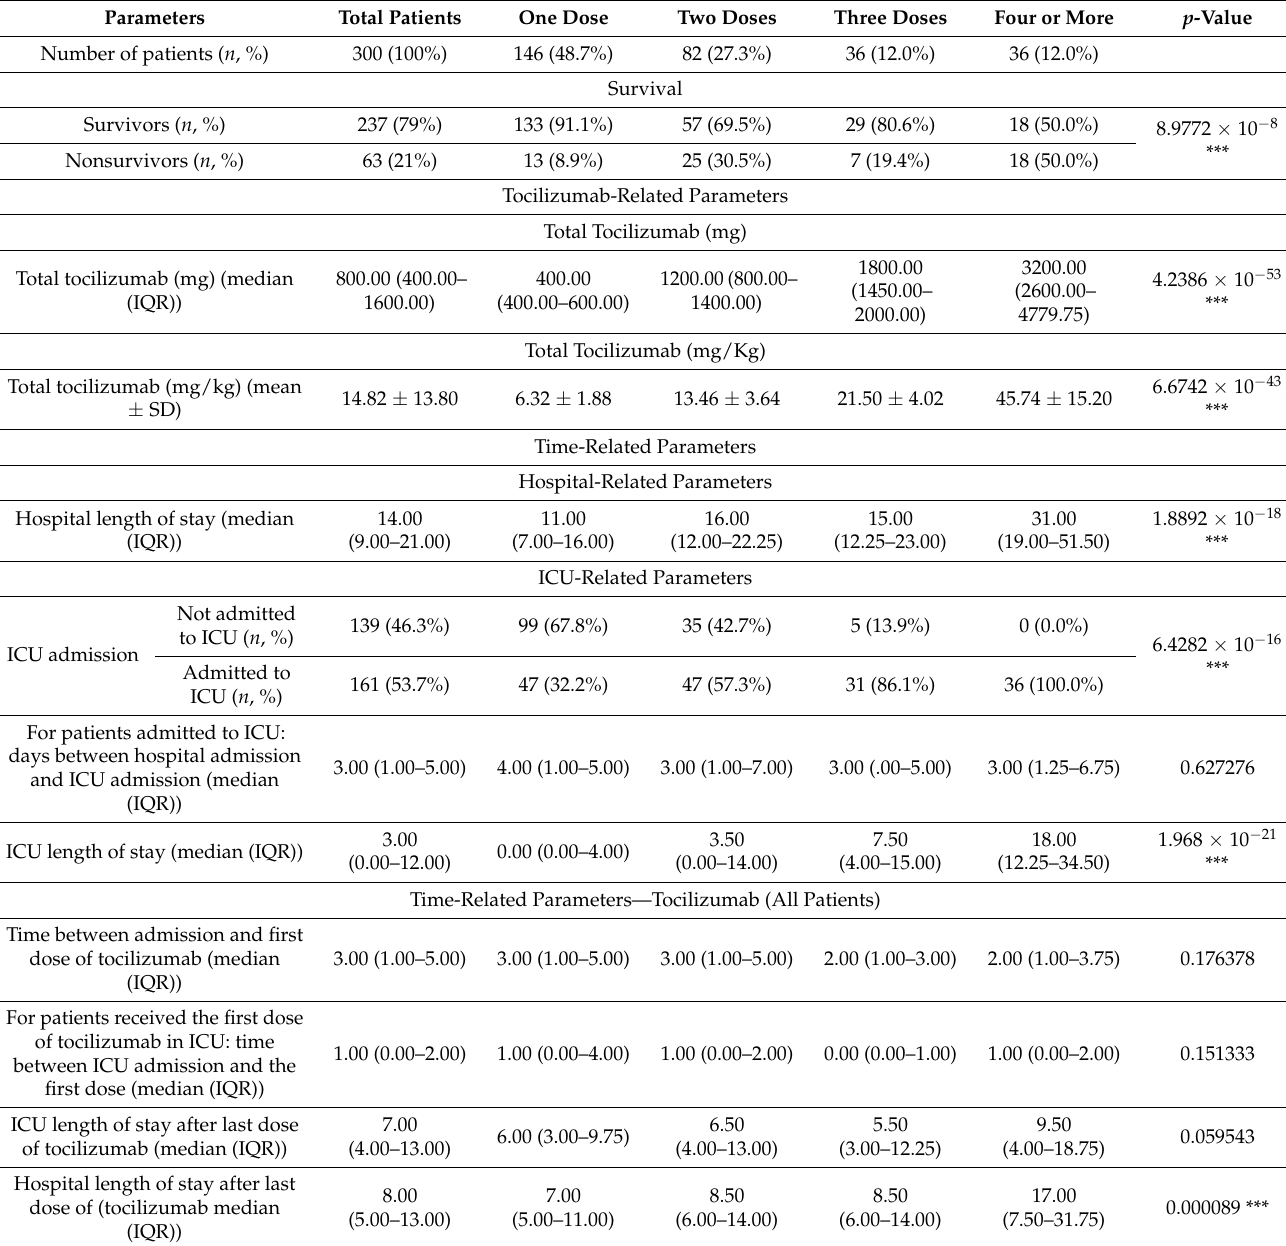
Table 3. Clinical outcomes for COVID-19 patients who received different doses of tocilizumab, categorized based on the number of doses administered to the